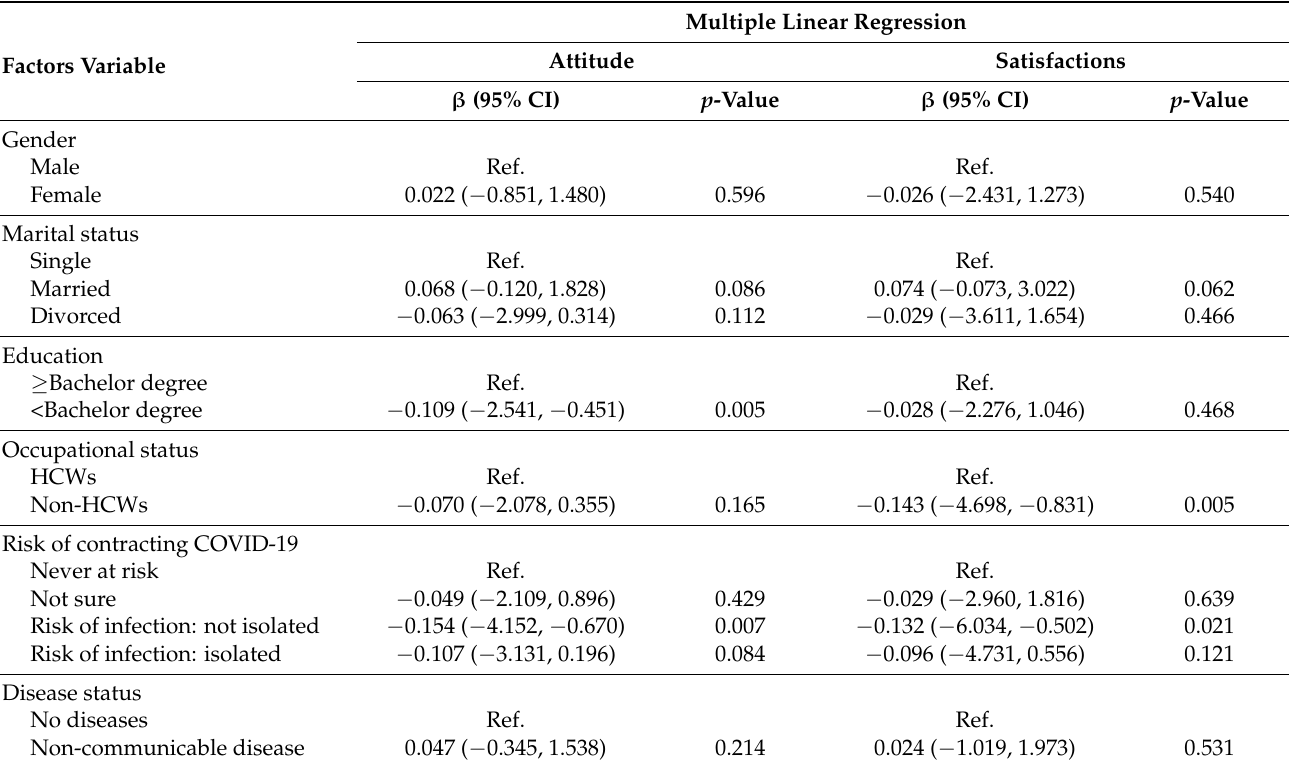
Table 3. Association between socio-demographic variables and attitude and satisfaction